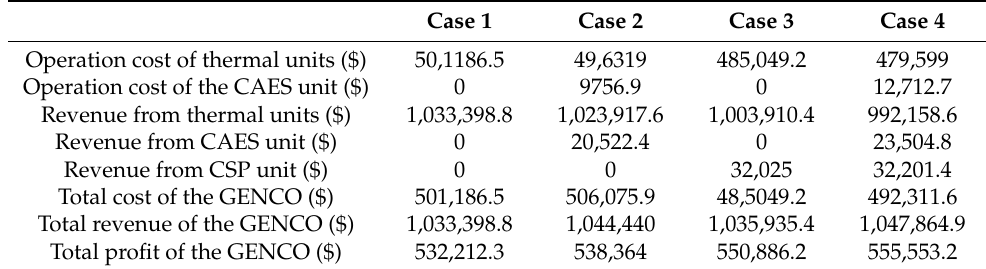
Table 4. Simulation results of the four